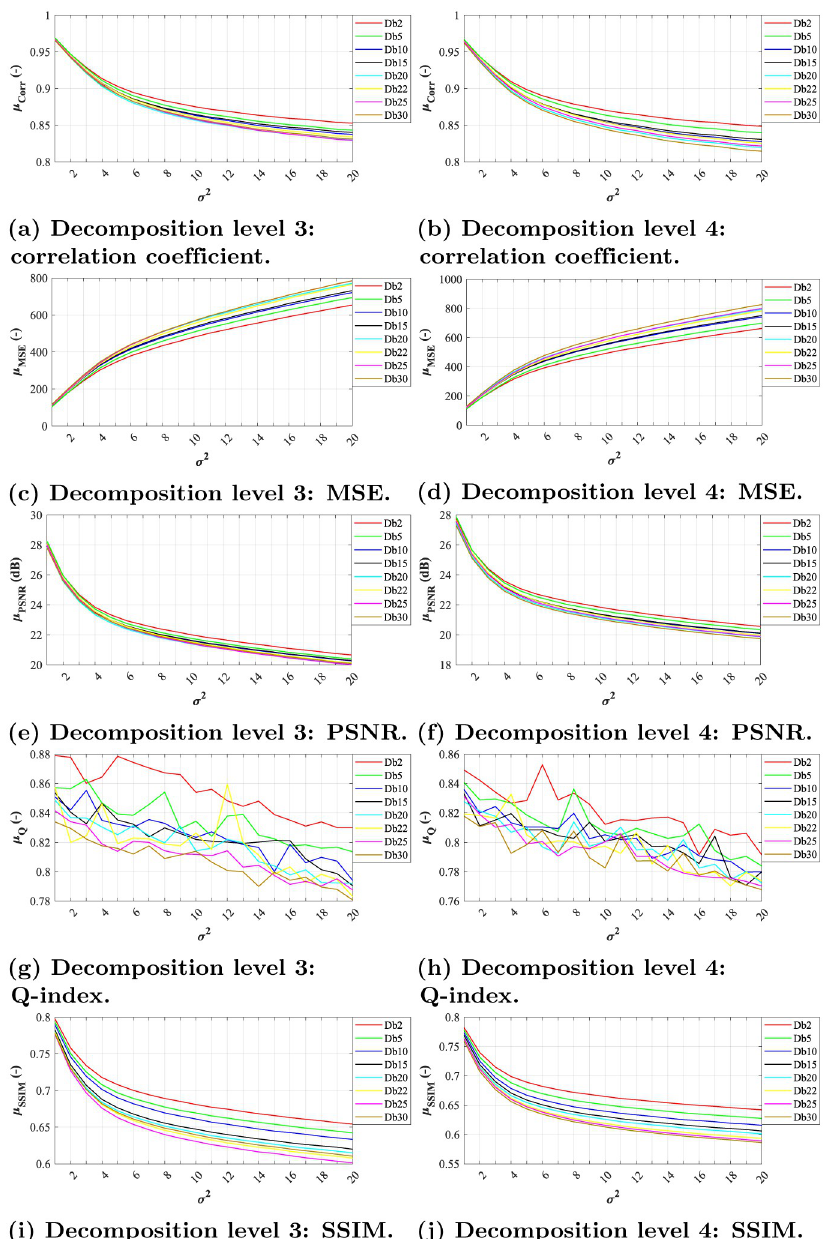
Fig 10. A comparative analysis of speckle noise ( μ = 0, σ 2 = {0.1, 0.2, ... , 2}) for Daubechies wavelets with decomposition level 3. (a) Decomposition level 3: correlation coefficient. (b) Decomposition level 4: correlation coefficient. (c) Decomposition level 3: MSE. (d) Decomposition level 4: MSE. (e) Decomposition level 3: PSNR. (f) Decomposition level 4: PSNR. (g) Decomposition level 3: Q-index. (h) Decomposition level 4: Q-index. (i) Decomposition level 3: SSIM. (j) Decomposition level 4: